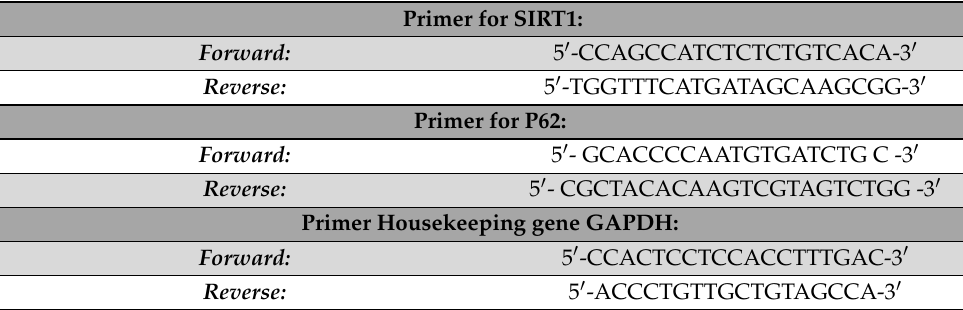
Table 1. Primers of SIRT1 and